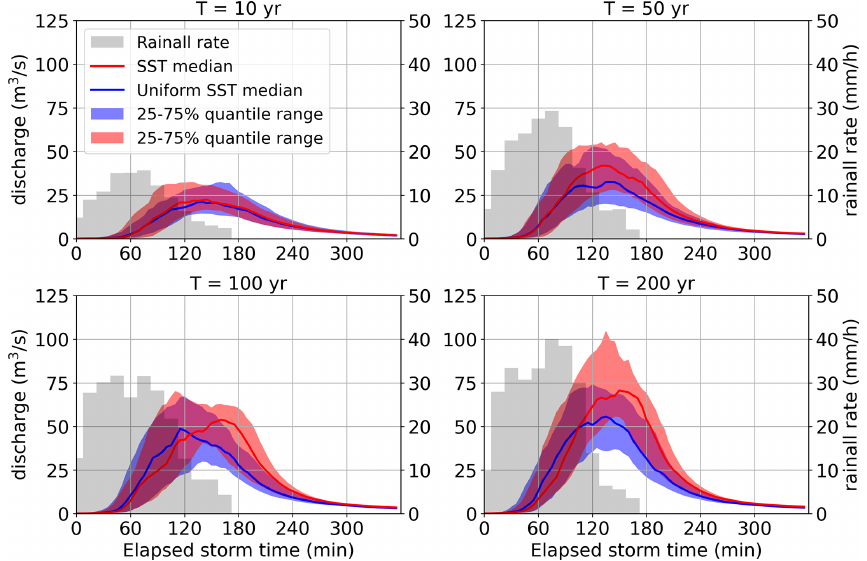
Figure 5. Time series of simulated hydrographs for Franklintown based on the 3h design storms from 10- to 200-year return periods with spatially uniform (blue) and spatially distributed (red) rainfall. The grey bar indicates the median value of the basin-averaged rainfall rate.